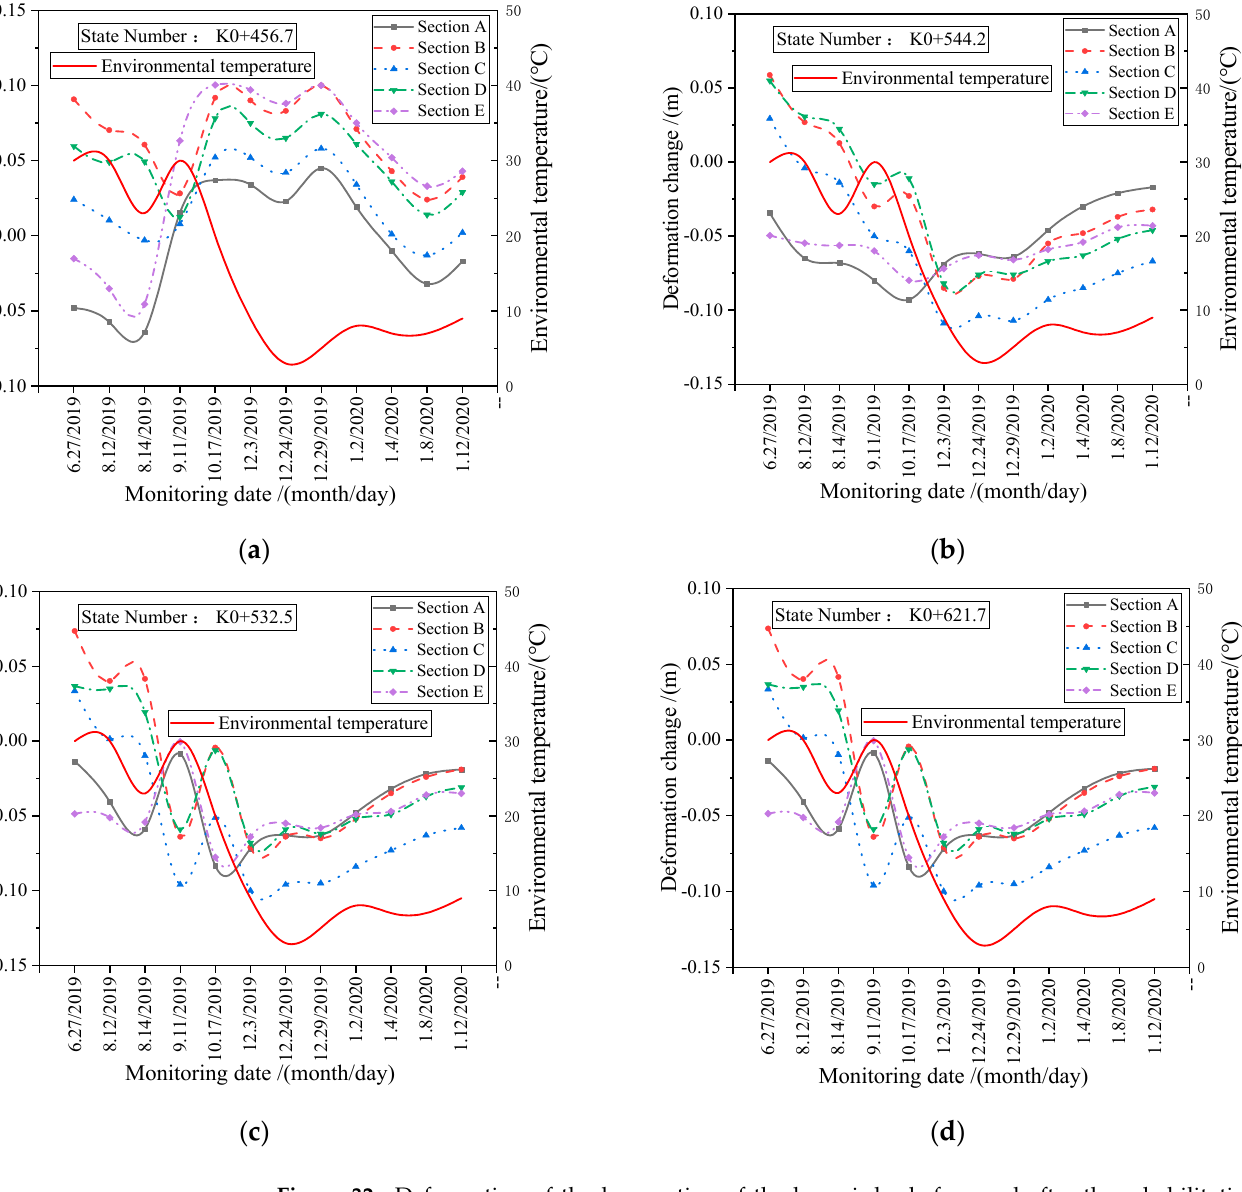
Figure 32. Deformation of the key section of the box girder before and after the rehabilitation measures. ( a ) End of the box girder above abutment #1. ( b ) mid-span of the main span of the box girder. ( c ) Section of hanging rod #11. ( d ) End of the box girder above abutment